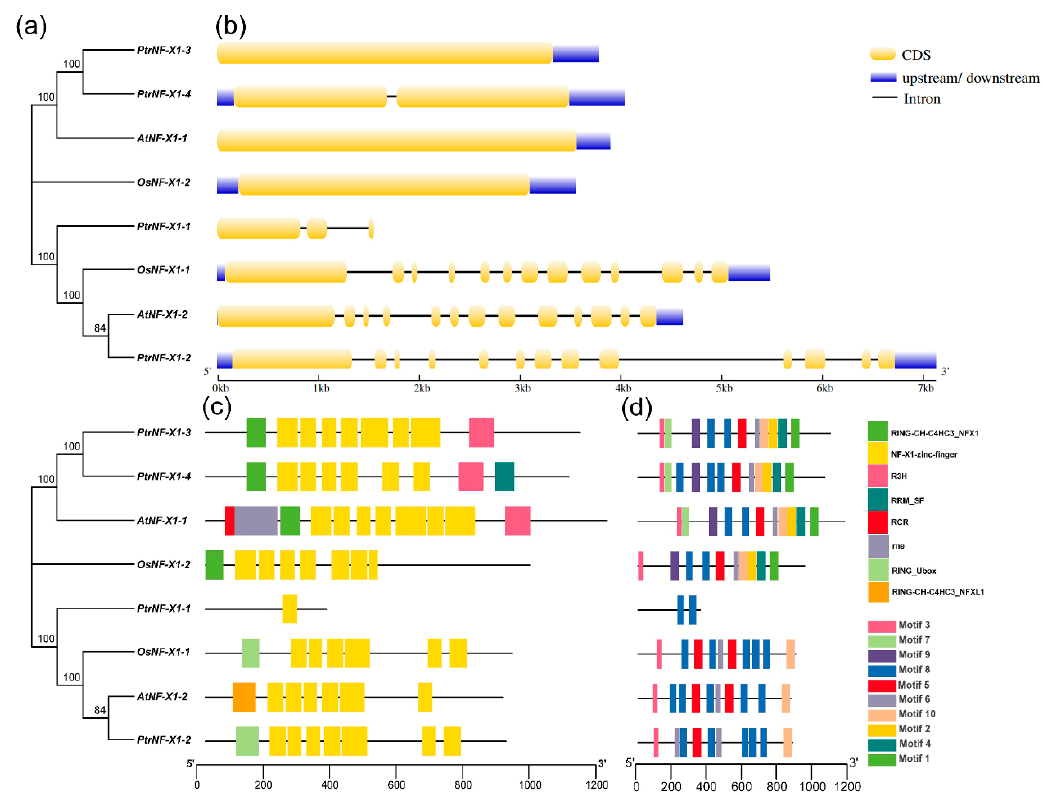
Figure 2. Phylogenetic, gene structure, conserved protein structure, and motif analyses of NF-X1 gene from A. thaliana , O. sativa , and P. trichocarpa . ( a ) Phylogenetic tree composed of total length amino acid sequences from NF-X1 proteins. ( b ) Exon–intron structure analysis of NF-X1 genes. Blue boxes represent UTR regions; yellow boxes indicate exons; black lines represent introns. ( c ) Conserved protein domain analysis of NF-X1 proteins. ( d ) Motif distribution of NF-X1 members. The length of each pattern is displayed proportionally.